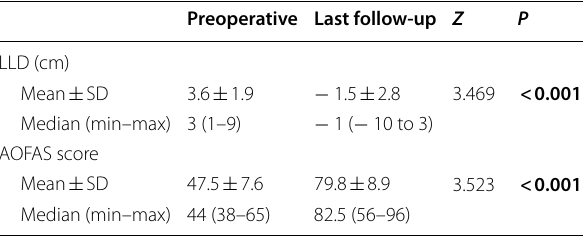
Table 4 Comparison between the values preoperatively and at last follow‑up of the LLD and AOFAS score